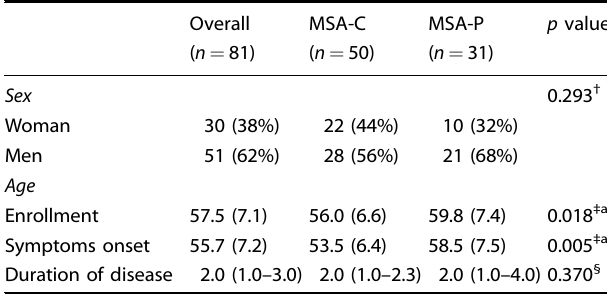
Table 1. Demographic characteristics of MSA patients. Table 2. Clinical and imaging characteristics were compared between MSA-C and MSA-P patients with HCBs.